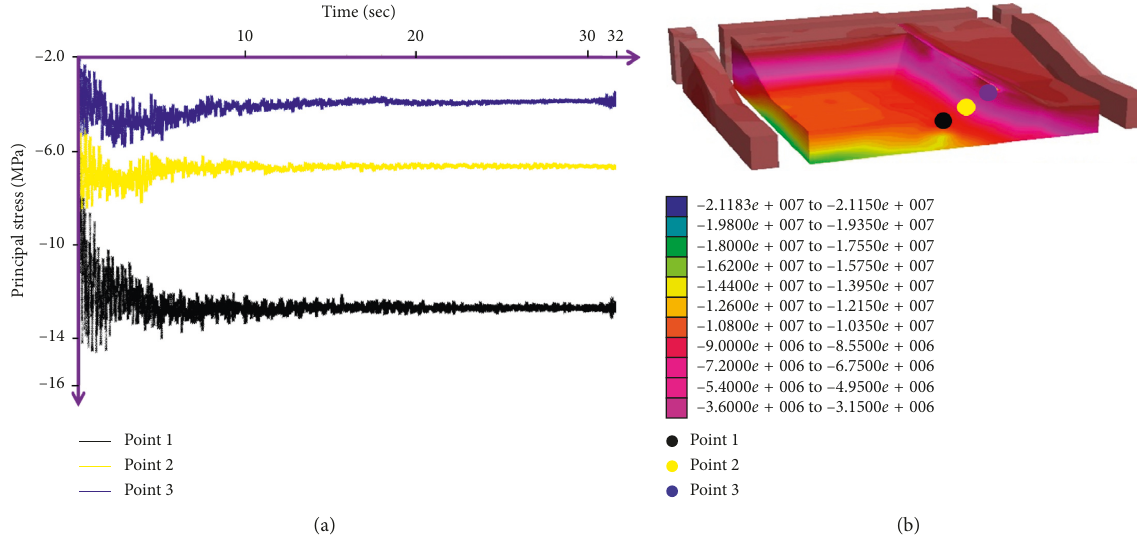
Figure 18: (a) Principal stress-time graphic for the Italy earthquake. (b) Contour plot diagram for 32 nd second of the Italy earthquake.